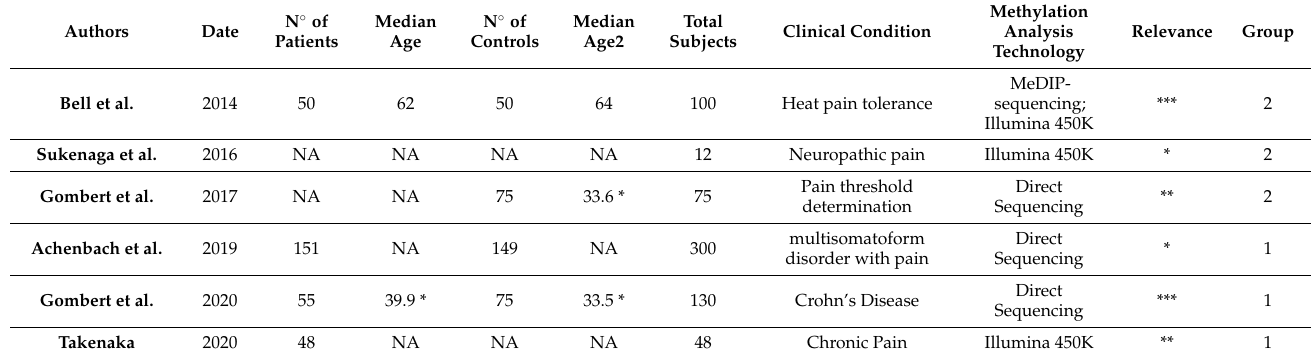
Table 1. Characteristics of studies included in meta-analysis: Authors; Date: Bibliographic